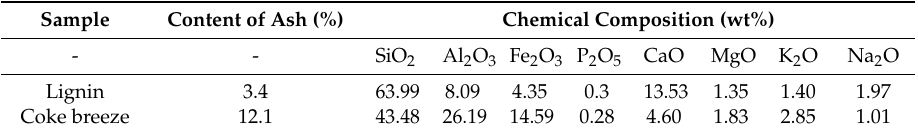
Table 4. Chemical composition (wt%) of ash samples as determined by X-ray fluorescence (XRF) spectrometry.